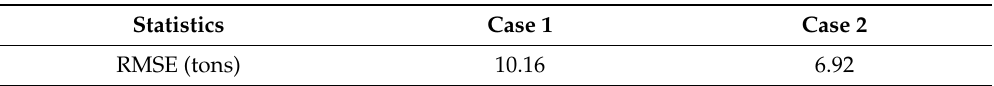
Table 8. RMSE of optimal DNN model for predicted ore production during 10 working days (case 1) and predicted values excluding 7 November (case 2).